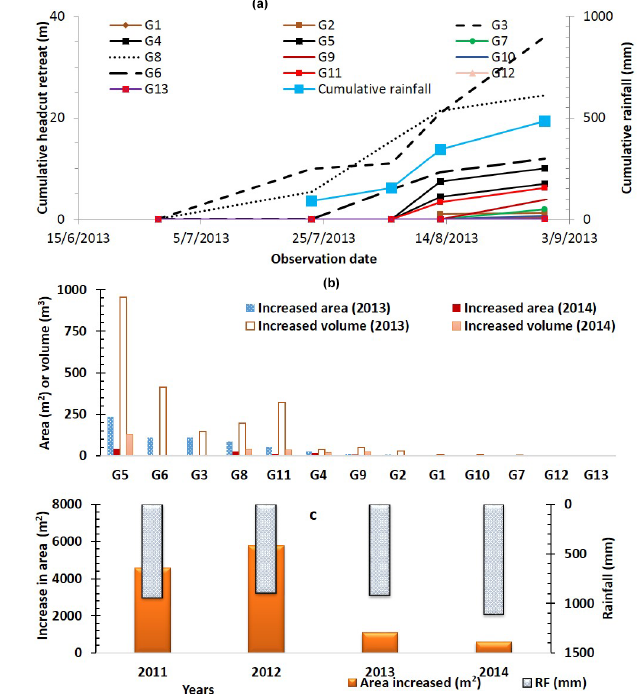
Figure 4. The observed expansion of the 13 study gullies in the De- bre Mawi watershed (see Fig. 2 for gully location): (a) cumulative headcut retreat and rainfall during the 2013 rain phase, (b) increase in gully surface area and volume during the 2013 and 2014 rain phases, and (c) increase in the combined gully surface area and the total summer rainfall (RF) between 2011 and